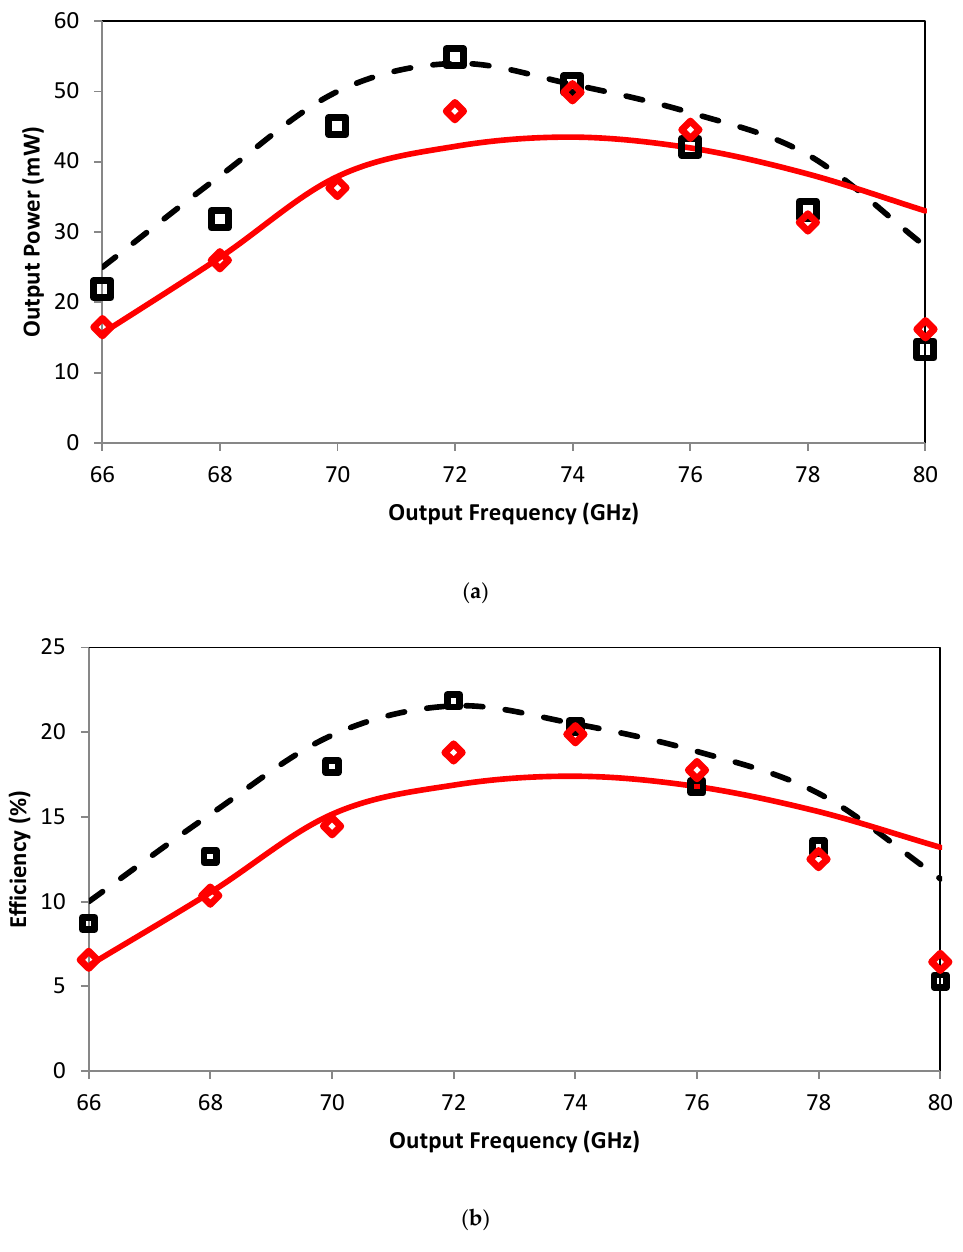
Figure 3. Output power ( a ) and efficiency ( b ) measurements (symbols) and simulations (lines) for MMIC (squares) and hybrid (diamond) circuits for 250 mW input power.